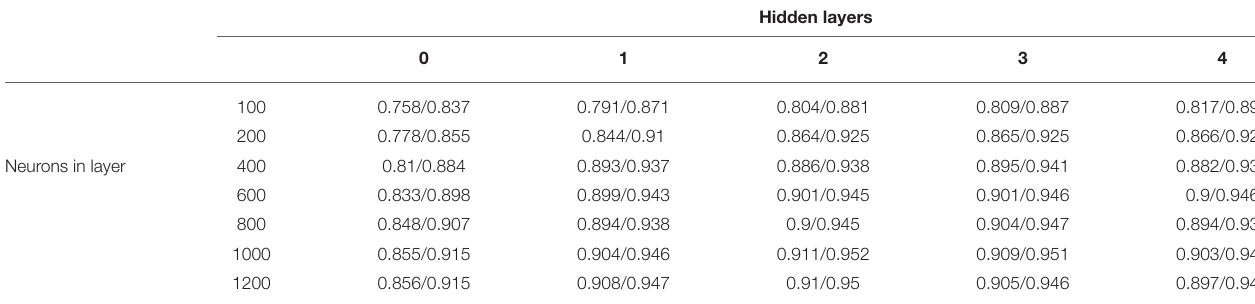
TABLE 4 | (A) The confusion matrix of the NN for 23 × 23 micropatterns, with four hidden layers and 800 neurons in each layer.